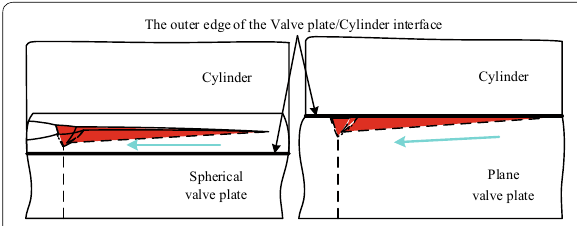
Figure 9 Comparison of the triangular grooves in the interface between the spherical surface and the